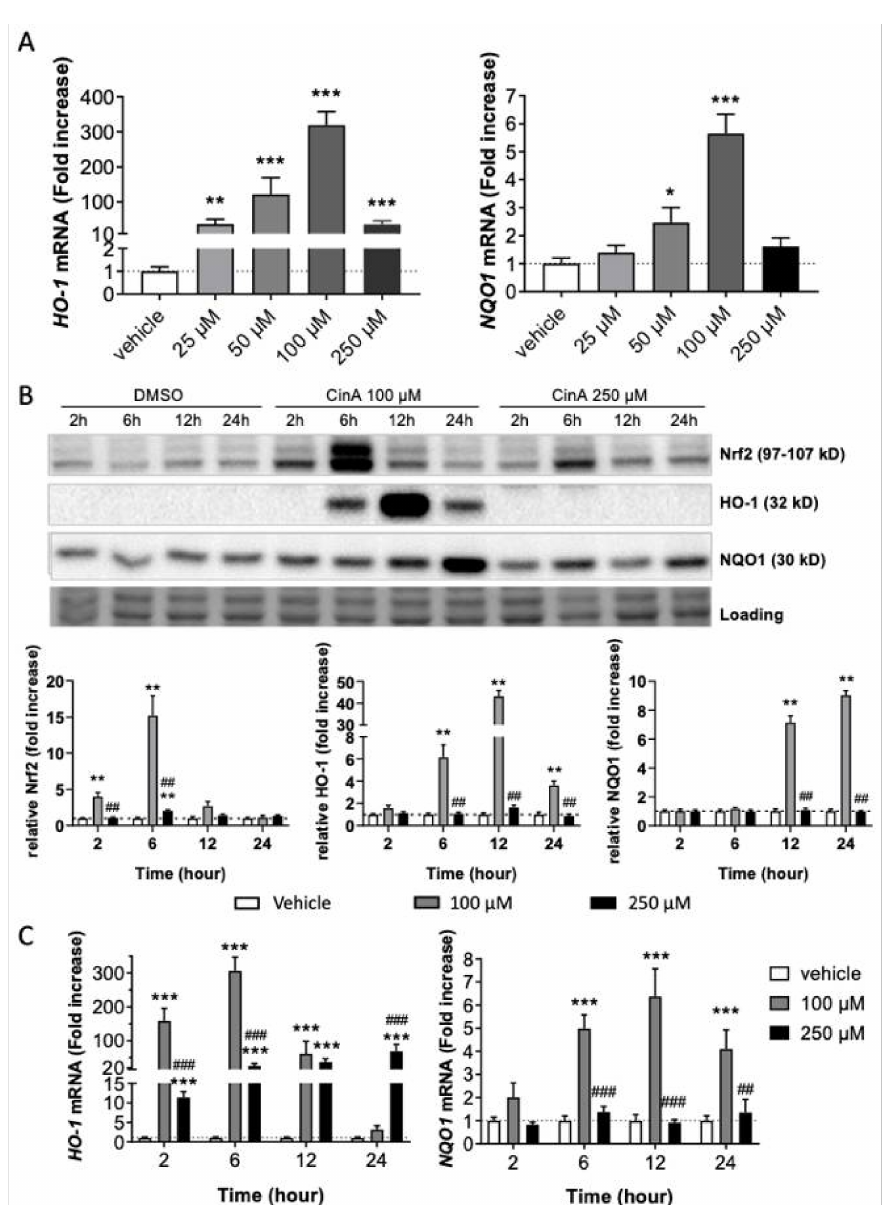
Figure 1. Nrf2 pathway activation in response to CinA. KC were exposed to different concentrations (25–250 µ M) for 2–24 h. ( A ) mRNA level of HO-1 and NQO1 measured by RT-qPCR after 6 h of exposure to different concentrations (25, 50, 100, and 250 µ M) of CinA and DMSO 0.1% as the vehicle control. ( B ) Western blot and relative quantification of Nrf2, HO-1, and NQO1 after exposure to CinA or DMSO 0.1% (2, 6, 12, and 24 h). Representative of 6 independent experiments. ( C ) mRNA level of HO-1 and NQO1 measured by RT-qPCR after exposure to 100 and 250 µ M of CinA and DMSO 0.1% as the vehicle control (2–24 h). Data represent the results of 5–16 independent experiments and are expressed as the mean ± SEM. ( A – C ) * Represents the statistical difference between CinA and vehicle-treated cells. (B,C), # Difference between 100 µ M and 250 µ M-treated cells. *, p -value < 0.05, **, ## p -value < 0.01, and ***, ### p -value < 0.001 (Mann–Whitney